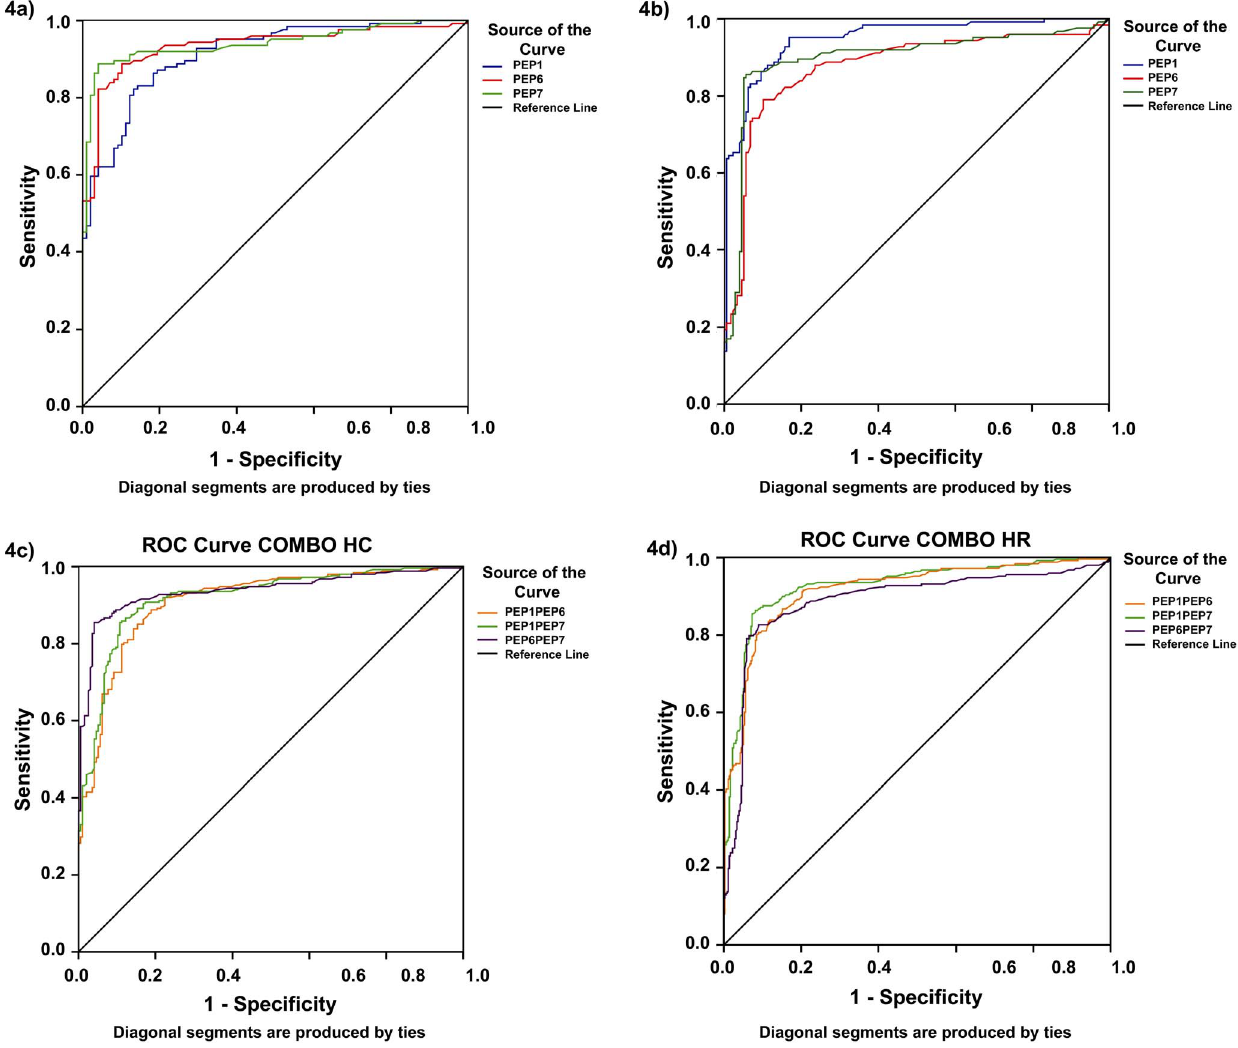
Figure 4. ROC curves representing the performance of P1, P6 and P7 BSA-peptide conjugates on lateral flow format. (A) ROC curves for reactivity of individual BSA-peptide conjugates with sera from healthy subjects and all smear-positive TB patients. (B) ROC curves for reactivity of individual BSA-peptide conjugates with sera from close/household contacts/NTBLD patients/HIV + TB- patients as reference standard, and all smear- positive TB patients. (C) ROC curves representing the additive performance of P1 + P6, P1 + P7 and P6 + P7 conjugates for reactivity with sera from all smear-positive TB patients and healthy PPD-/PPD + /PPD-unknown subjects as reference standard. (D) ROC curves representing the additive performance of P1 + P6, P1 + P7 and P6 + P7 conjugates for reactivity with sera from all smear-positive TB patients and from close/household contacts/ NTBLD patients/HIV + TB- patients as reference standard.